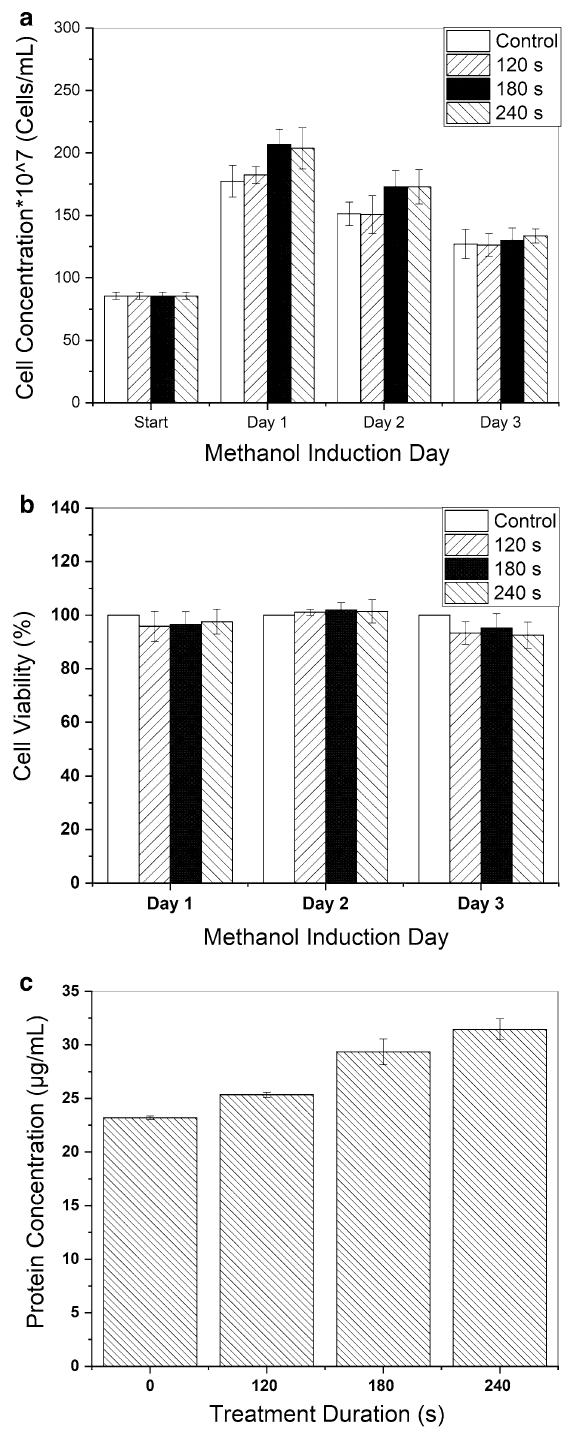
Figure 3. Effect of CAP treatment over three times duration on ( a ) Cell growth and ( b ) viability. The cell concentrations were obtained by measuring OD600 of the culture medium, and cell viability was assessed by MTT assay. ( c ) Total protein concentration on the last day of methanol induction, obtained by Bradford assay, indicated an increasing trend proportional to the treatment time. The error bars are standard